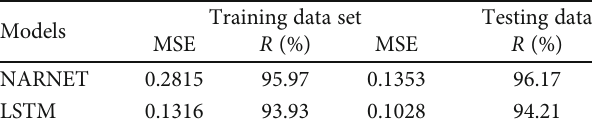
Table 6: Performances of the NARNET LSTM and ANN models to predict WQI.